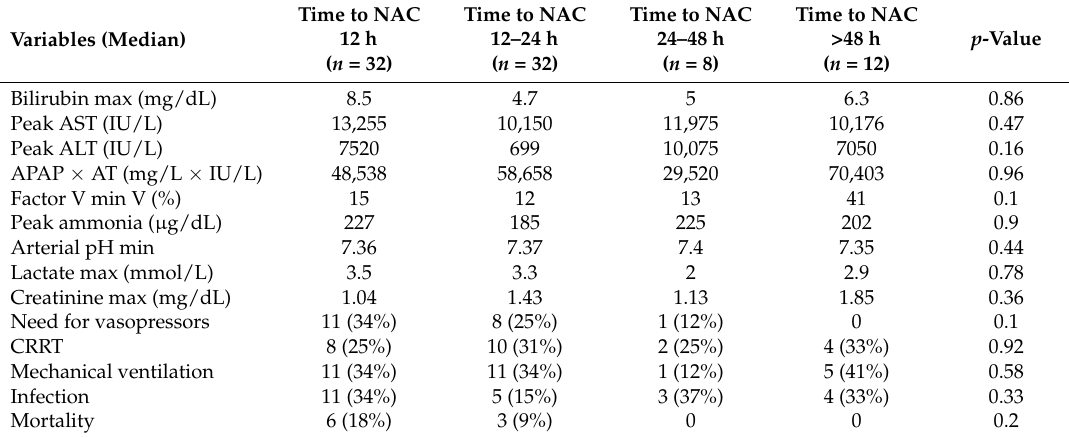
Table 2. Relationship between the delay of NAC therapy and biological variables and complications. Legend: APAP × AT, paracetamol–aminotransferase product; CRRT, continuous renal replacement